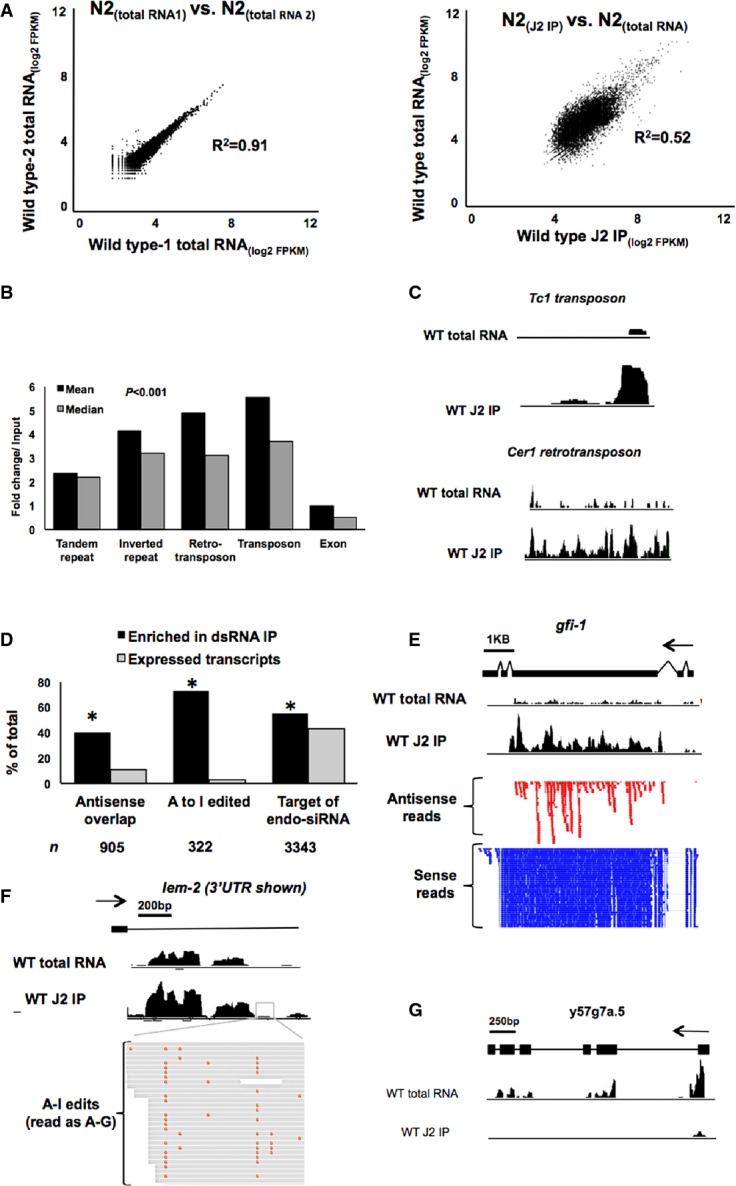
Immunoprecipitation with J2 antibody selects for dsRNA in wild-type worm extractsA The J2 anti-dsRNA antibody immunoprecipitates a subset of RNAs from wild-type extracts. Plotted are RPKMs(log2) for two independent wild-type input RNA-seq datasets (left graph) and for a J2-IP RNA-seq dataset versus input RNA (right graph). 9,086 transcripts are shown. R2 values for each plot are displayed in the graph.B The fold change (in RPKM) over input (y-axis) of all significantly enriched repetitive transcripts (type indicated on x-axis) and all exons (corrected P < 0.001) in wild-type J2-IP RNA-seq. Graph shows both mean (black bars) and median (gray bars) fold enrichment/input.C Coverage tracks (black bumps) of alignments to consensus sequences of representative transposons enriched in J2-IP RNA compared to total RNA. Coverage track height was set to the same value for both input RNA and J2-immunoprecipitated RNA, and height is proportional to abundance of each region.D The percentage of total transcripts (gray bars) with potential dsRNA of three types (antisense overlap determined from Thierry-Mieg & Thierry-Mieg, 2006, A-to-I RNA editing taken from Supplementary Table S4 and siRNA targets taken from Warf et al, 2012) and the percentage of each of those transcript types enriched by J2-IP (in three independent biological replicates; black bars, *P-value < 0.001 (hypergeometric distribution); n = number of genes analyzed in each structural category).E–G Examples of transcripts enriched in the J2-IP RNA-seq. The gfi-1 locus (E) expresses an antisense transcript, as shown by both antisense (red) and sense (blue) reads. The 3′ UTR of lem-2 (F) undergoes dsRNA-specific A-to-I RNA editing. The editing pattern in the boxed region is shown. (G) Example of transcript not enriched by J2-IP (y57g7a.5). Black arrows indicate direction of transcription.